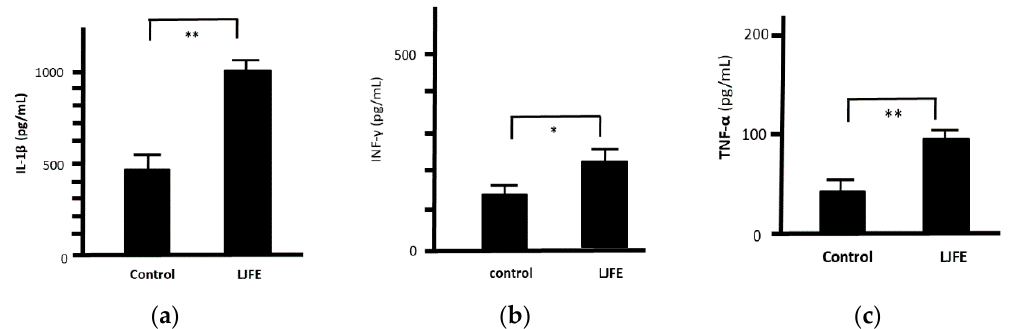
Figure 8. Ex Vivo e ff ect of Lonicera japonica flower bud extract (LJFE) on the levels of cytokines secreted from mice intraperitoneal macrophages. Mice were orally administered LJFE (2 g / kg) for seven days, and the levels of interleukin ( a ) (IL)-1 β , ( b ) interferon (IFN)- γ , and ( c ) tumor necrosis factor (TNF)- α in the culture supernatant of intraperitoneal cells collected from mice were measured by ELISA. Data are presented as mean ± S.D. ( n = 6). * p < 0.05, ** p < 0.01, t